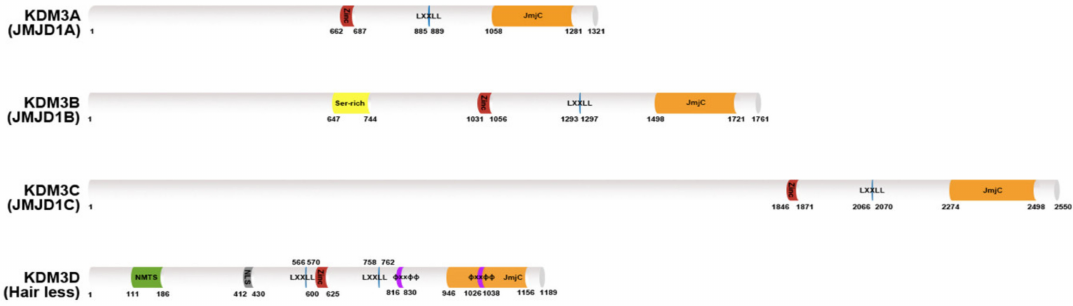
Figure1. Lysine-specifichistonedemethylase3(KDM3)demethylaseproteinstructures.